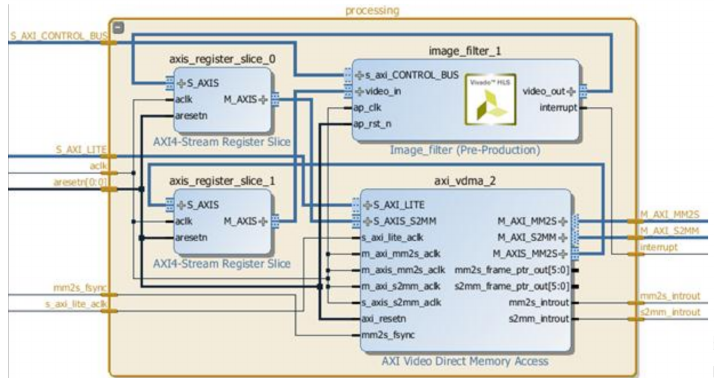
Figure 4. Detailed scheme of the ‘processing’ block, showing the internal organization that is composed of: two AXI4-Stream Register Slice cores, which are multi-purpose pipeline registers that are able to isolate timing paths between master and slave; an AXI Video Direct Memory Access that provides high-bandwidth direct memory access between memory and AXI4-Stream video type target peripherals; and an ‘image filter’ IP core (generated by the Vivado HLS) that performs the video processing. The ‘image filter’ IP core is the only reconfigurable block.